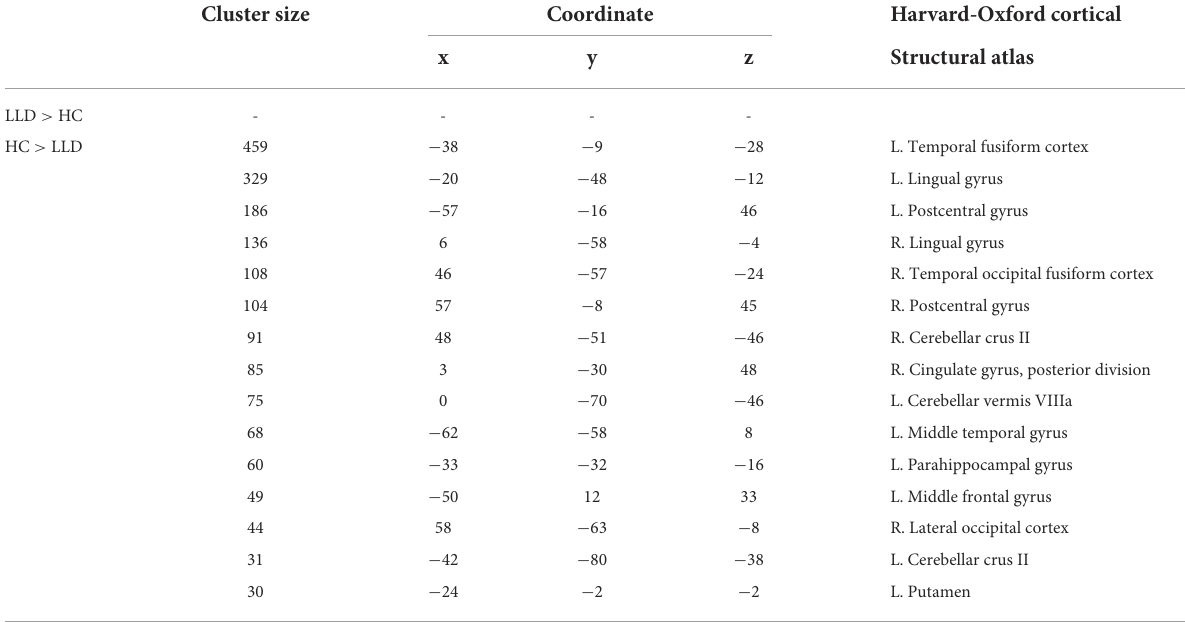
TABLE 1 Regional differences in gray matter volume between patients with late-life depression (LLD) and healthy controls (HC). Cluster size Coordinate Harvard-Oxford cortical x y z Structural atlas - -